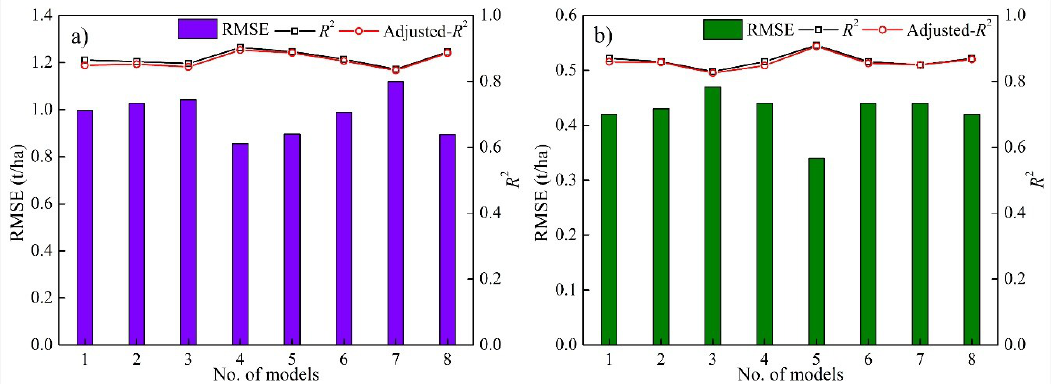
Figure 3. The RMSE (t/ha), coefficient of determination ( R 2 ), and adjusted R 2 of RF models driven by different predictors for maize ( a ) and sunflower ( b ).